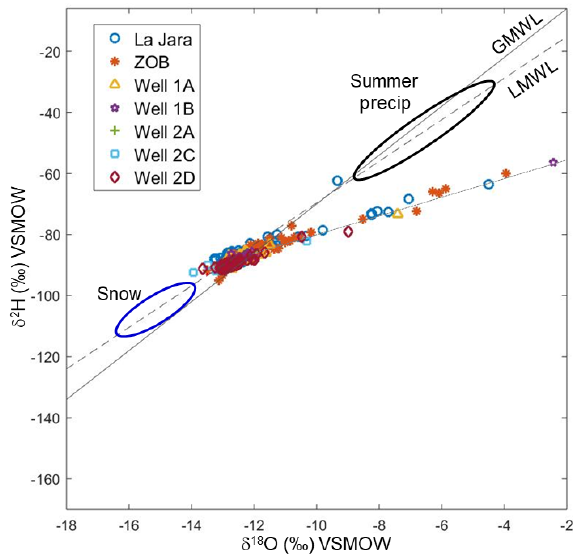
Figure 9. Oxygen ( δ 18 O) and stable hydrogen ( δ 2 H) isotope val- ues of surface waters from La Jara and ZOB flumes, groundwaters, and volume-weighted mean ranges of summer precipitation (pre- cip, taken from Zapata-Rios et al., 2015b) and snow (taken from Gustafson, 2008). The global meteoric water line (GMWL, solid line, slope of 8.0) and local meteoric water line (LMWL, slope of 6.8, dashed line from Broxton et al., 2009) are plotted for reference. Surface waters and site 1 groundwaters plot along an evaporation trend (dotted line, slope of